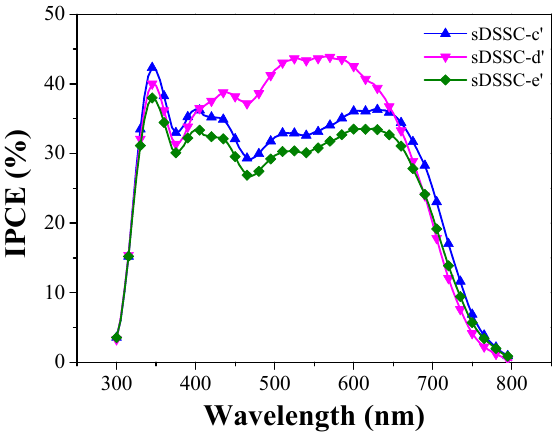
Figure 7. IPCE spectra for sDSSC-c’, d’ and e’ as a function of wavelength.